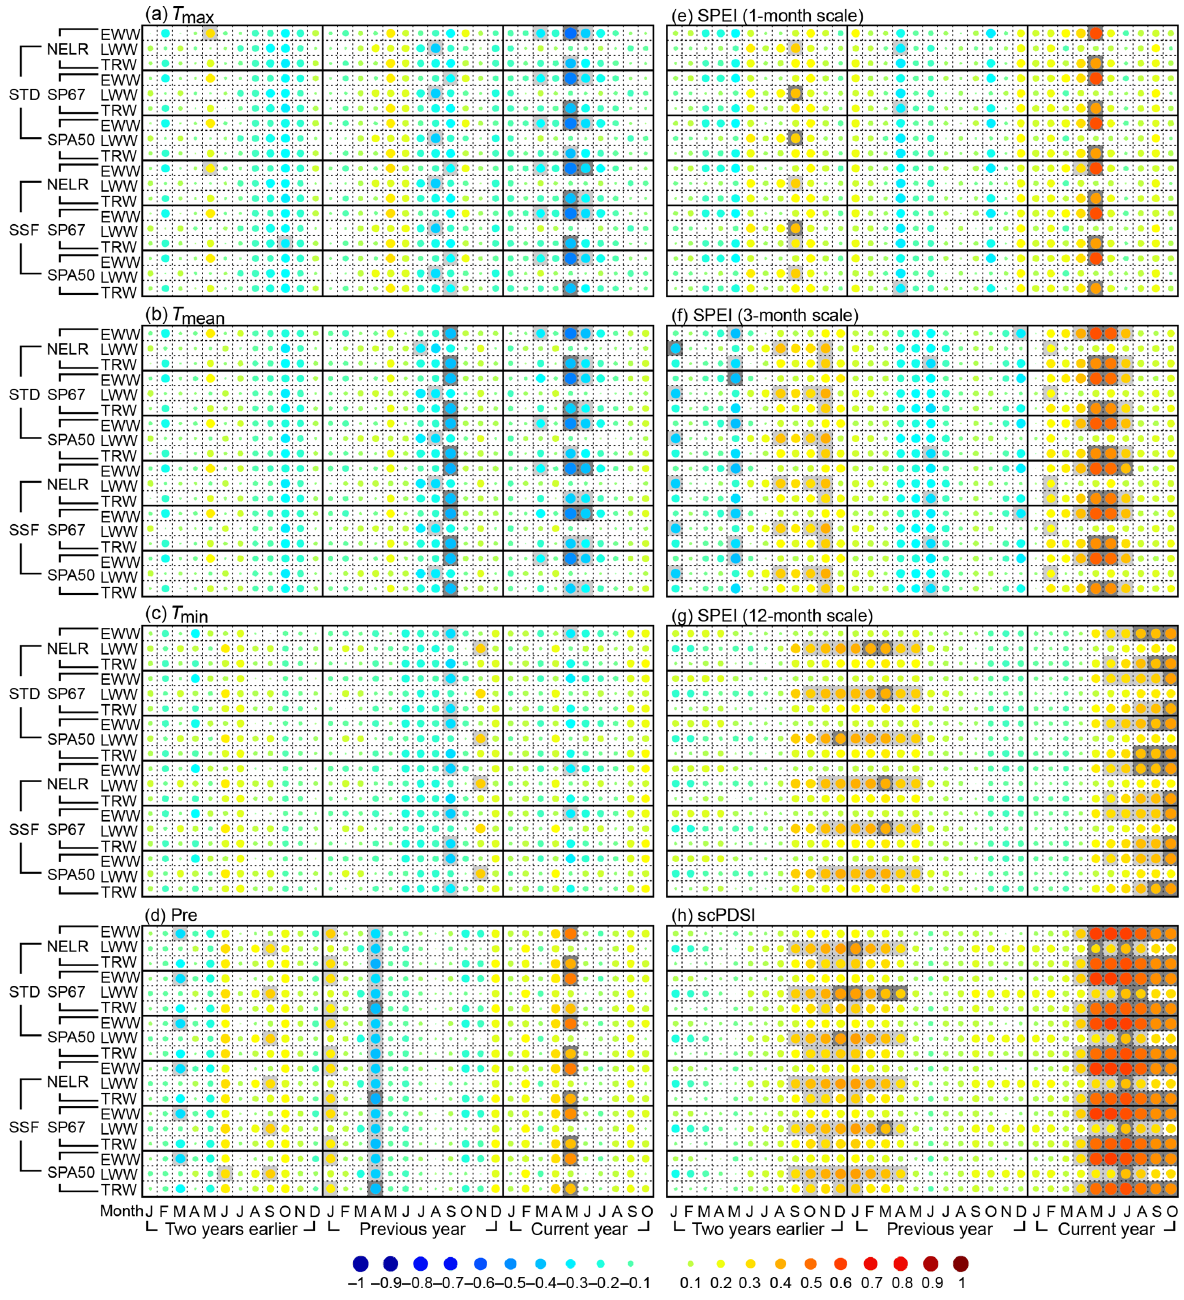
Figure 4. Matrix plots for the correlation coefficients between the prewhitened and linearly detrended tree-ring-width chronologies and monthly climate time series from January of 2 years earlier to October of the current year. The climatic factors are monthly (a) maximum temperature ( T max ), (b) mean temperature ( T mean ), (c) minimum temperature ( T min ), (d) total precipitation (Pre), (e) SPEI of 1-month scale, (f) SPEI of 3-month scale, (g) SPEI of 12-month scale, and (h) scPDSI. The EWW, LWW, and TRW represent the earlywood width, latewood width, and total tree-ring width, respectively. The correlation analyses were conducted for the period 1953–2005 for the scPDSI and for 1957–2005 for the other climatic factors. NELR, SP67, and SPA50 indicate the three detrending methods: (1) negative exponential functions combined with linear regression with negative (or zero) slope (NELR), (2) cubic smoothing splines with a 50% frequency cutoff at 67% of the series length (SP67), and (3) age-dependent splines with an initial stiffness of 50 years (SPA50). STD and SSF indicate the two standardization methods “standard” and “signal-free”, respectively. The correlation coefficients are reflected by the colored and different-size circles, which can be referred to using the color bar as shown at the bottom of the figure. The squares filled with light and dark gray indicate that the correlation coefficients are statistically significant at the 0.05 and 0.01 levels, respectively, which are tested using the Monte Carlo method (Efron and Tibshirani, 1986; Macias-Fauria et al., 2012). www.clim-past.net/15/1113/2019/ Clim. Past, 15, 1113–1131,